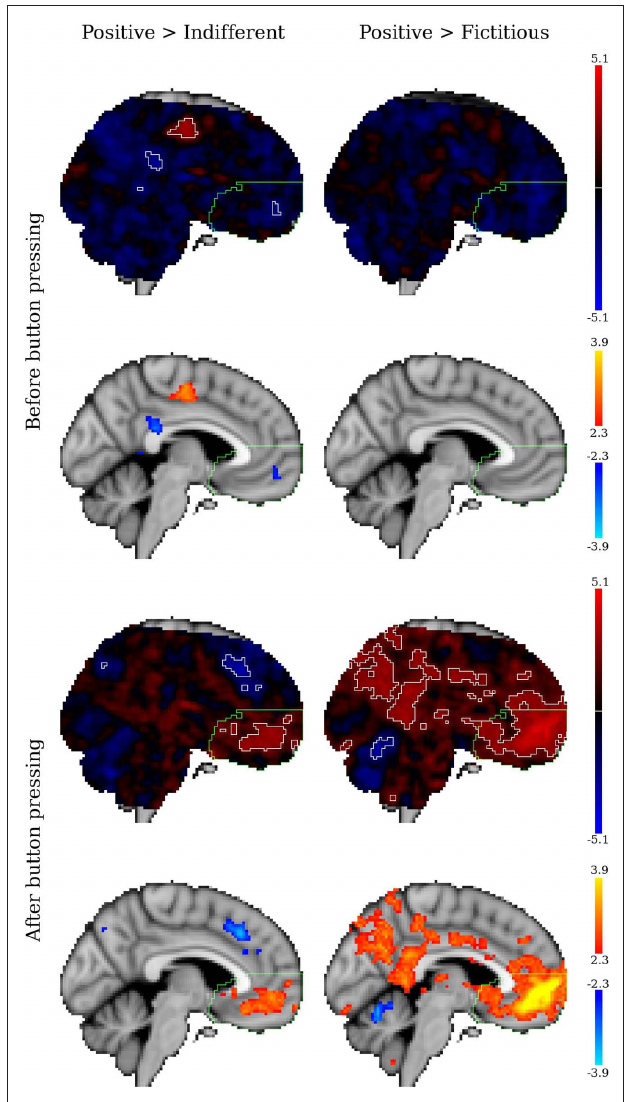
FIguRe 6 | Statistical z maps (unthresholded and thresholded) for the contrasts between positive versus indifferent brands and positive versus fictitious logos in the stimulus detailed analysis. The two top row maps represent the decision stage (before the response), and the two bottom row maps represent the period after the response (passive visualization). In the unthresholded images the significant clusters are outlined in white (for z > 2.3), the vmPFC is outlined in green. Sagittal views for x = − 04 (MNI152